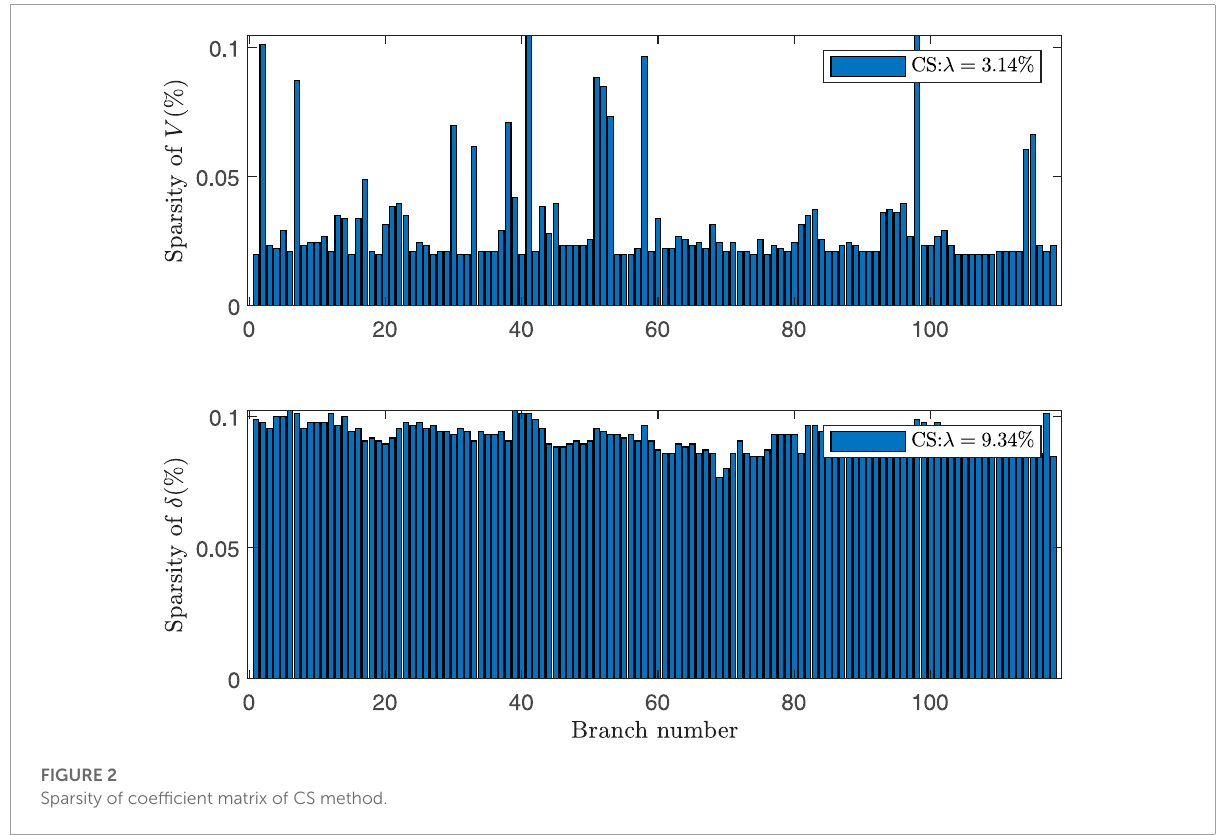
FIGURE 2 Sparsity of coefficient matrix of CS method.